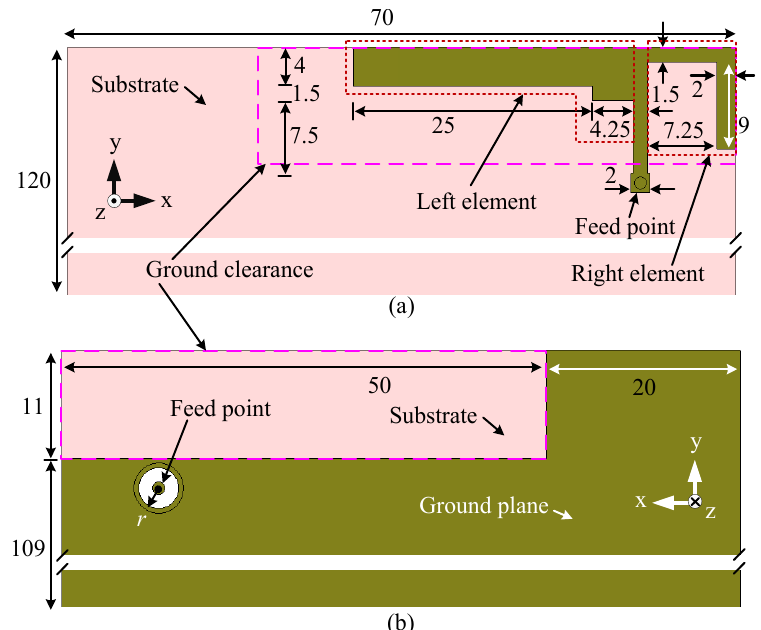
Figure 1. Configuration of the planar antenna (Ant#1) for LSA operation (1452–1492 and 2300–2400 MHz): ( a ) top view and ( b ) bottom view. All dimensions are in millimeters.